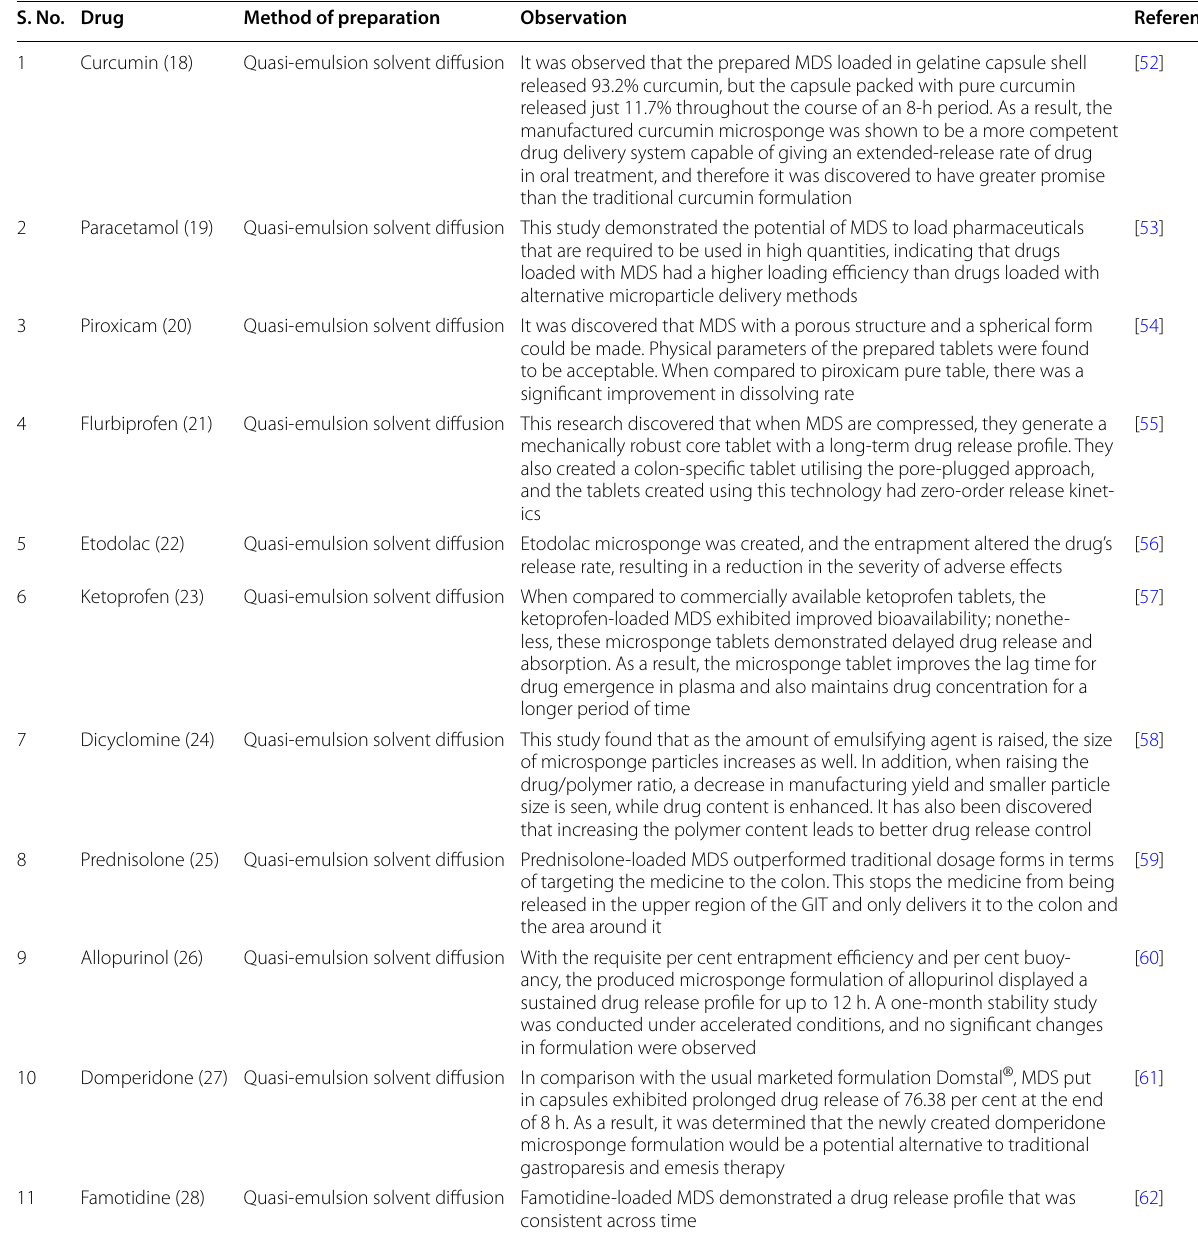
Table 6 Microsponge-based formulations for dermatological applications S. No. Drug Method of preparation Curcumin